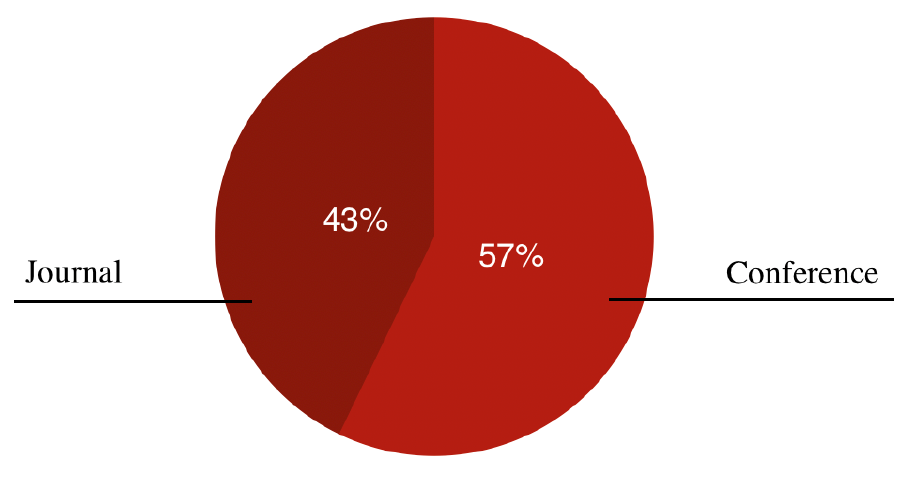
Figure 8. Percentage of studies published in journals and